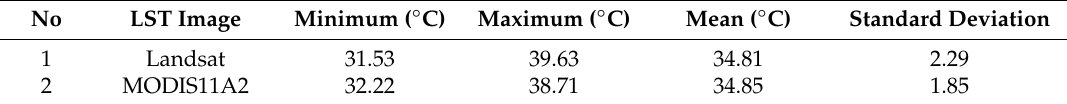
Table 4. Statistical comparisons between LST of Landsat and MOD11A2 images from 2001 to